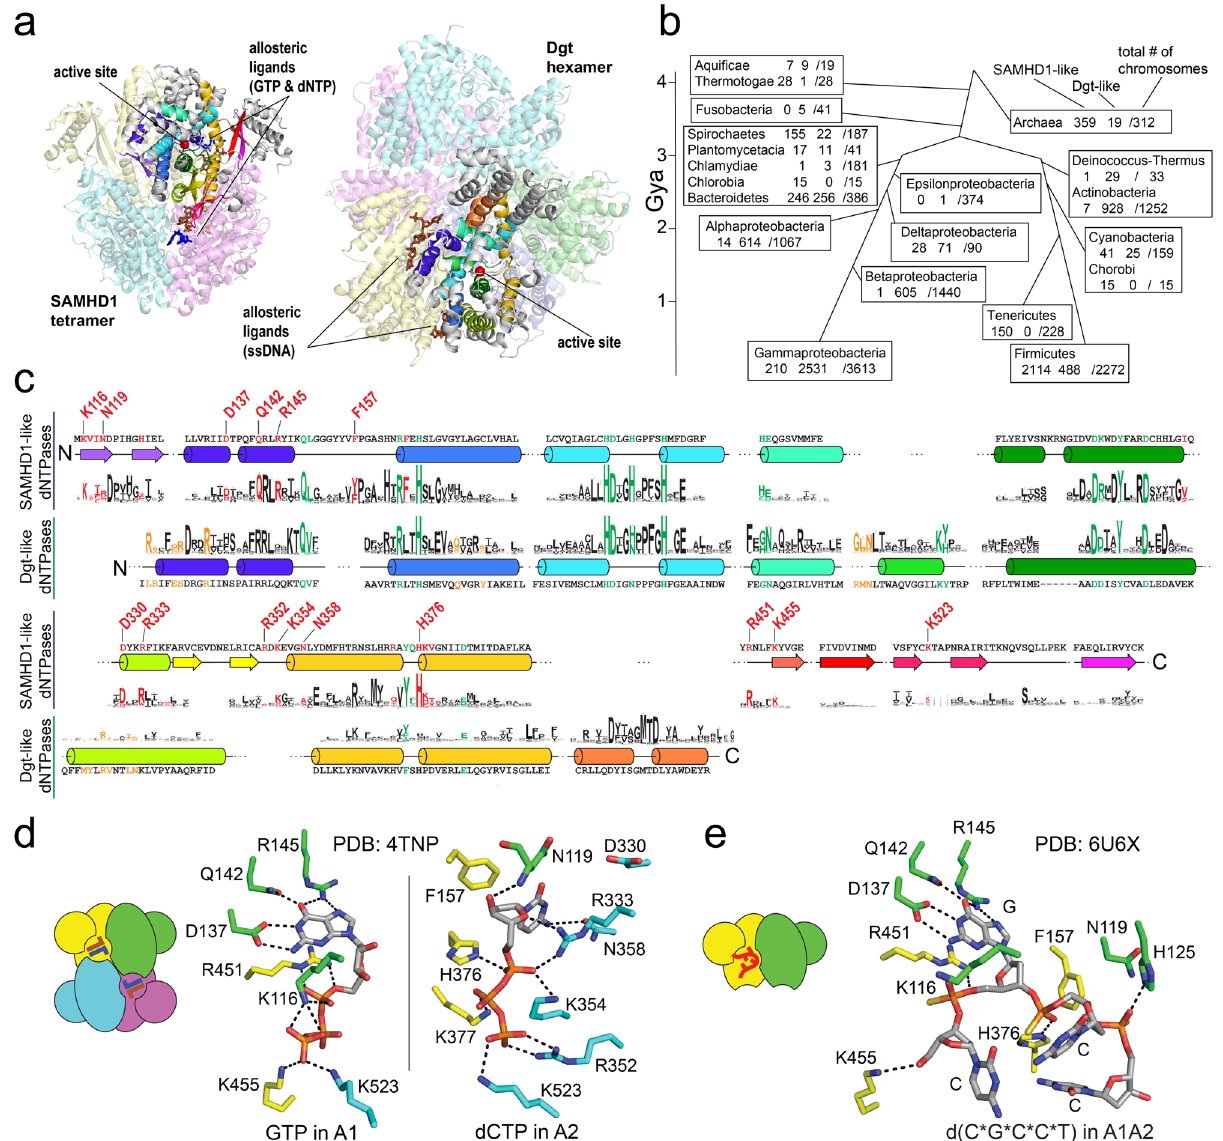
Fig. 5 Functional determinants of sequence conservation in prokaryotic SAMHD1-like dNTPases. a Cartoon representations of the SAMHD1 tetramer (PDB: 4BZC) and Dgt hexamer (PDB:4X9E). The two structures are shown such that the conserved secondary structure elements in one of the monomers (color-coded) are oriented the same way. b Census of HD-domain dNTPases in a database of complete prokaryotic chromosomes. The three numbers shown are the total number of identi fi ed SAMHD1-like dNTPases, Dgt-like dNTPases, and the total number of searched chromosomes, respectively. Each taxon is displayed linked to the time of its common ancestor with Gammaproteobacteria or Firmicutes 93 . c Sequence logo representations of multiple- sequence alignments for the SAMHD1-like and Dgt-like families of prokaryotic dNTPases. The secondary structure cartoons show the location of conserved secondary structure elements in the primary sequence of SAMHD1 and Dgt positioned above and below the secondary structure cartoons, respectively. Residues located within 5 Å of the active sites are colored green. Residues located within 5 Å of the allosteric ligands are colored red and orange in SAMHD1 and Dgt, respectively. Residues surrounding the SAMHD1 allosteric sites are also labeled. d Interactions of GTP and dCTP with the residues of the allosteric binding sites of SAMHD1 21 (PDB: 4TNP). e Interactions of the d(C*G*C*C*T) oligonucleotide with the allosteric sites